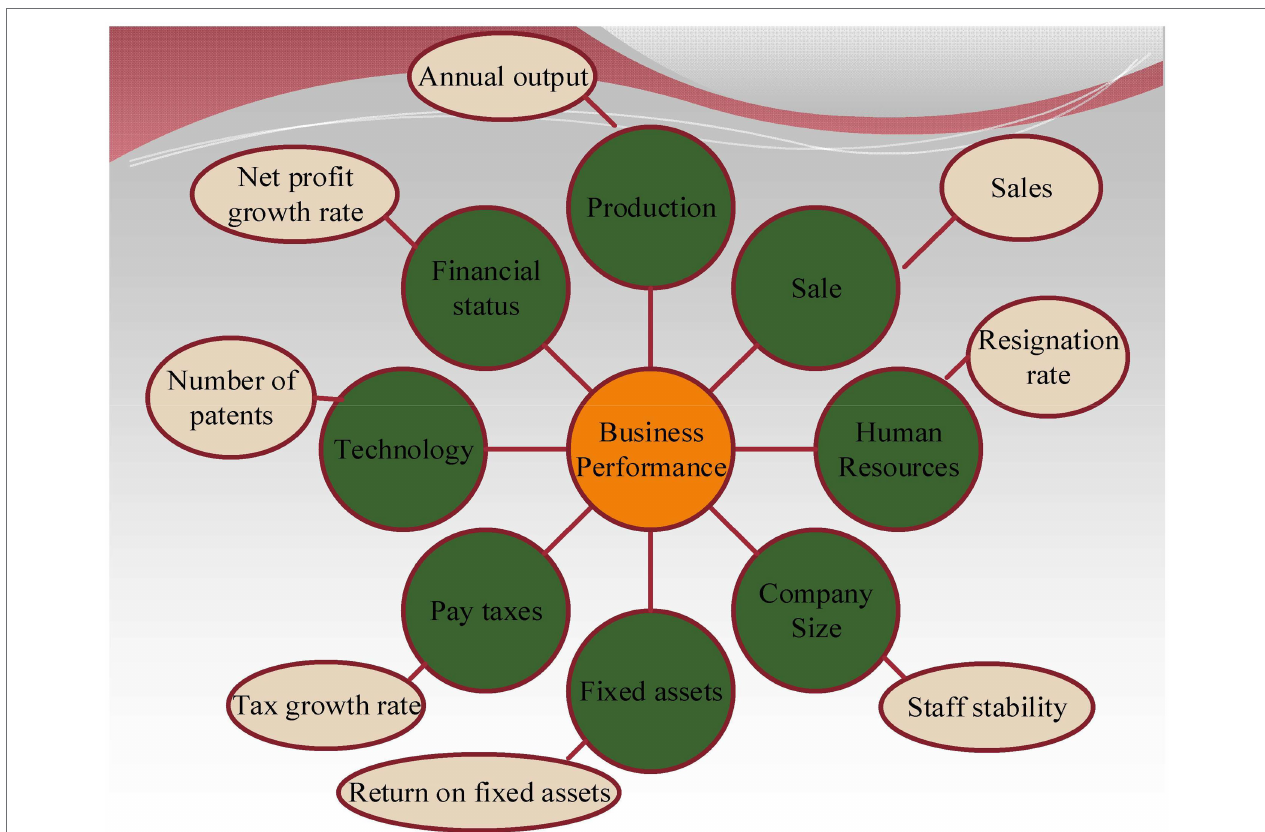
FIGURE 4 | Schematic diagram of corporate performance structure